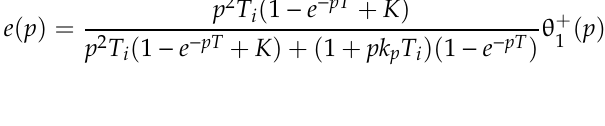
Figure 4. Small signal model of SRF-PLL with the initially proposed modification.